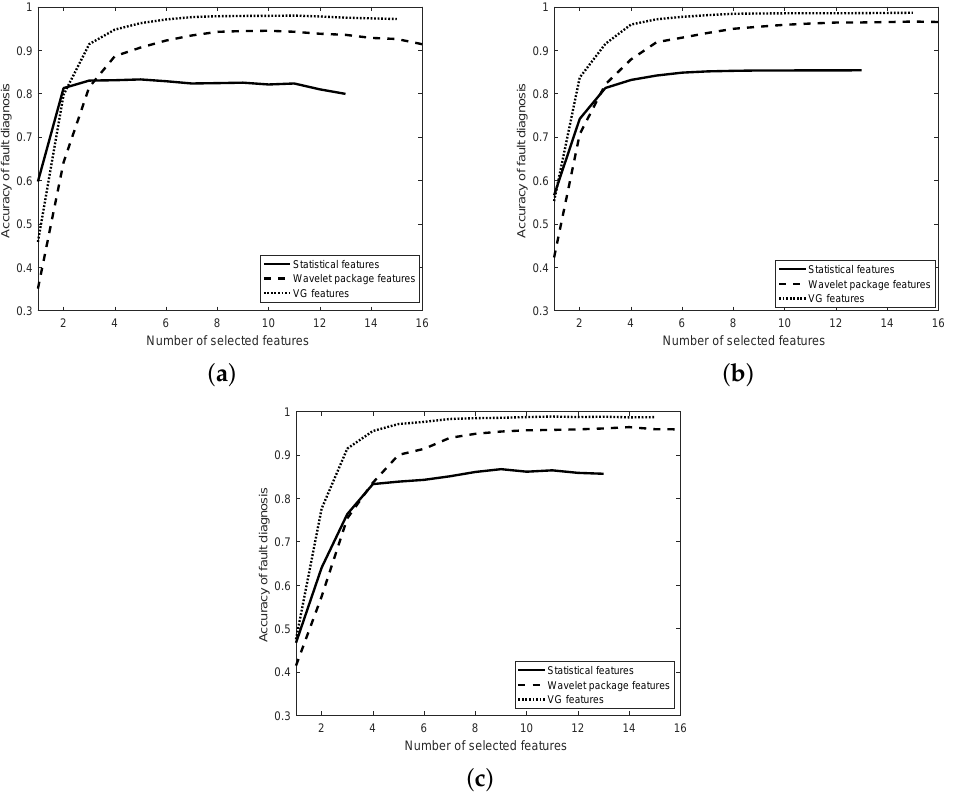
Figure 7. Estimated accuracy during feature selection for all features using the CWRU data. ( a ) KNN; ( b ) LSVM; ( c )